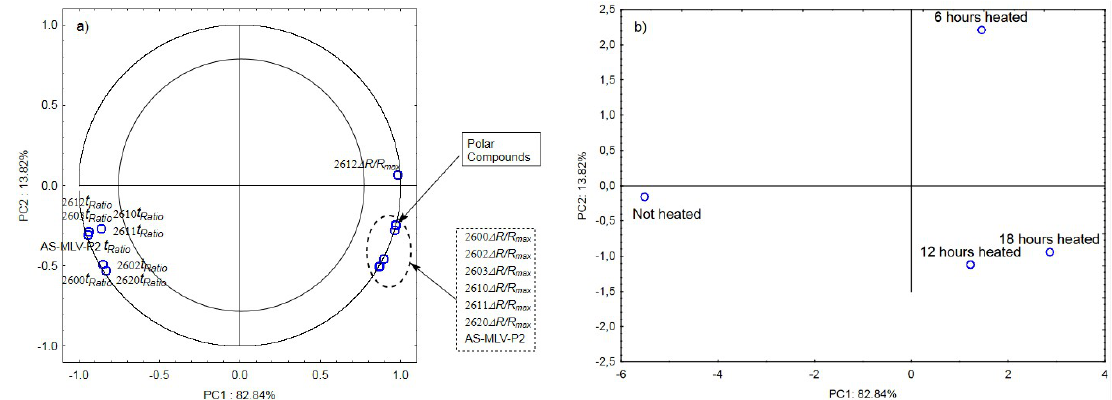
Figure 4. ( a )—Plot of two principal component loadings (PC1, PC2) from eight sensor readings and polar compounds